Question: According to the figure, is the described quantity increasing or decreasing?
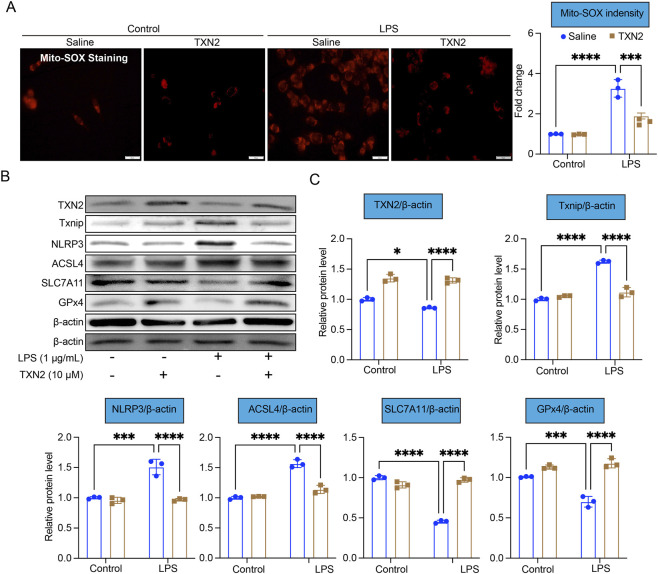
Answer: increasing